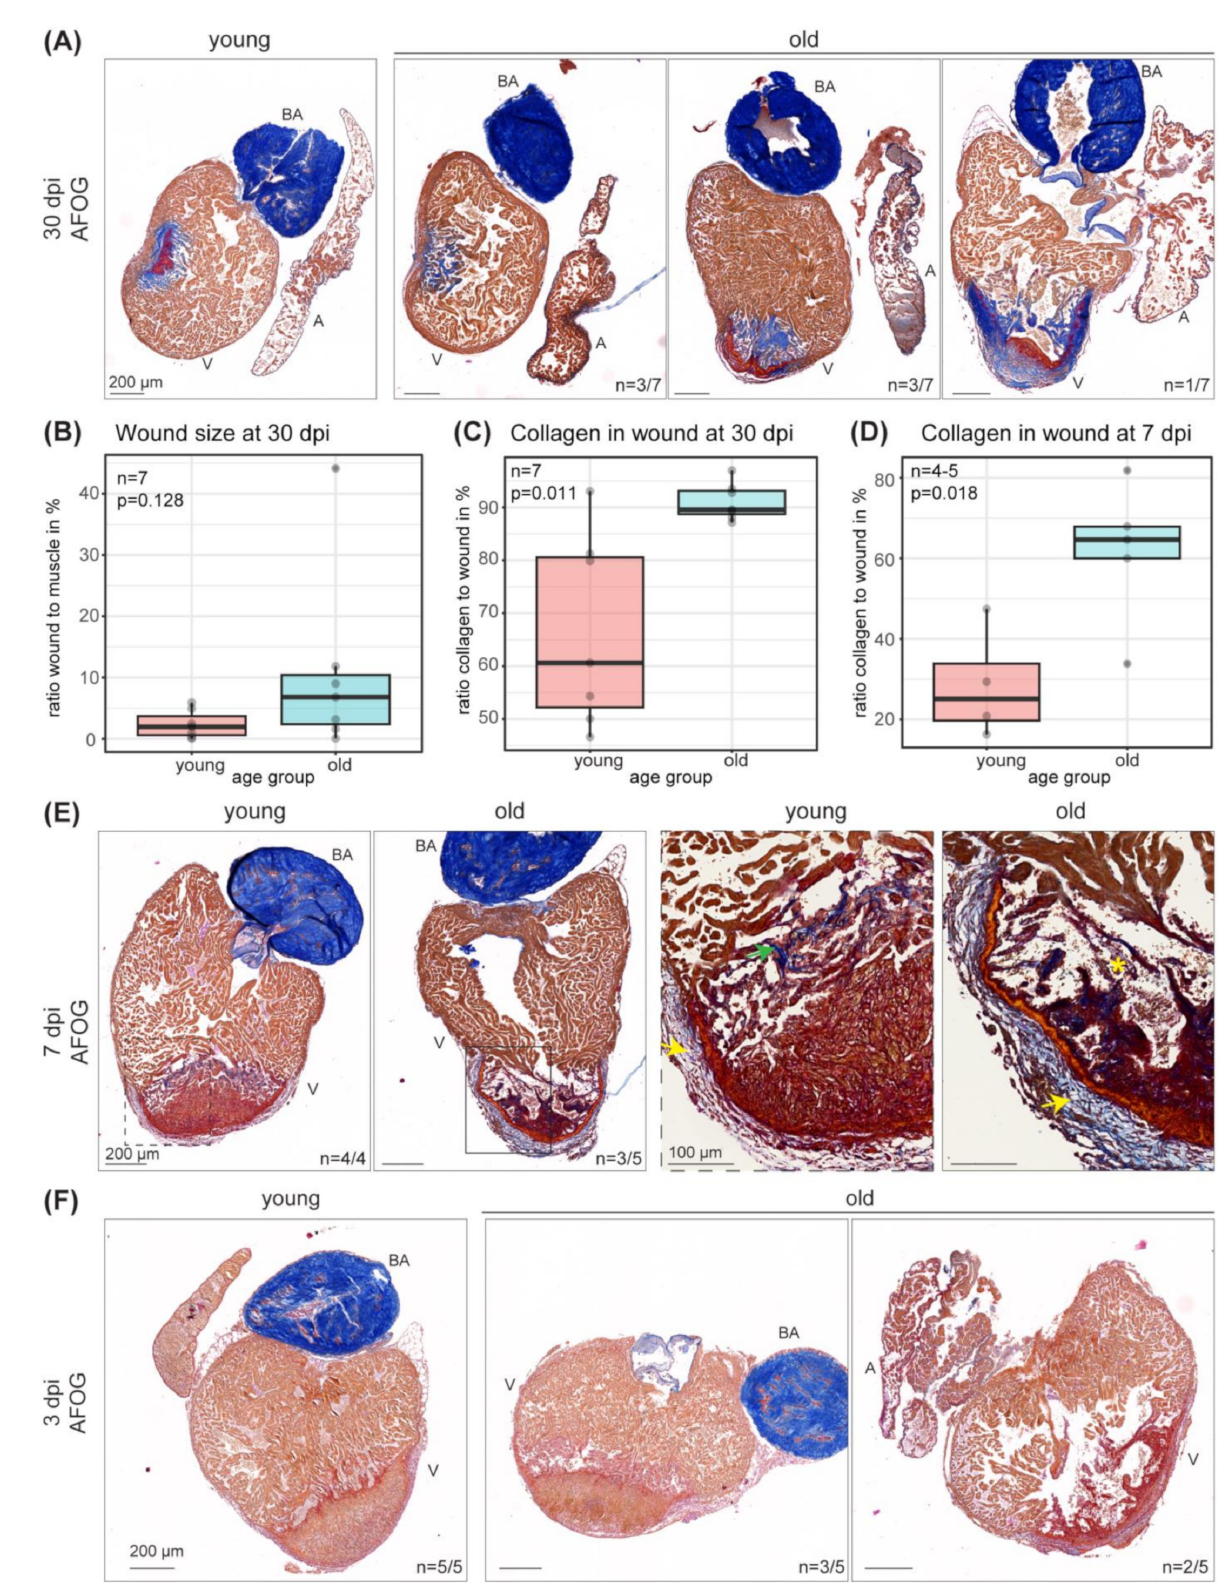
Figure 6. Wound size, regeneration response and collagen deposition changes upon cryoinjury in old compared to young hearts. ( A ) Acid fuchsin orange G (AFOG) staining of representative sections of young and old hearts 30 dpi visualizes the scar area in red (fibrin) and blue (collagen). Intact